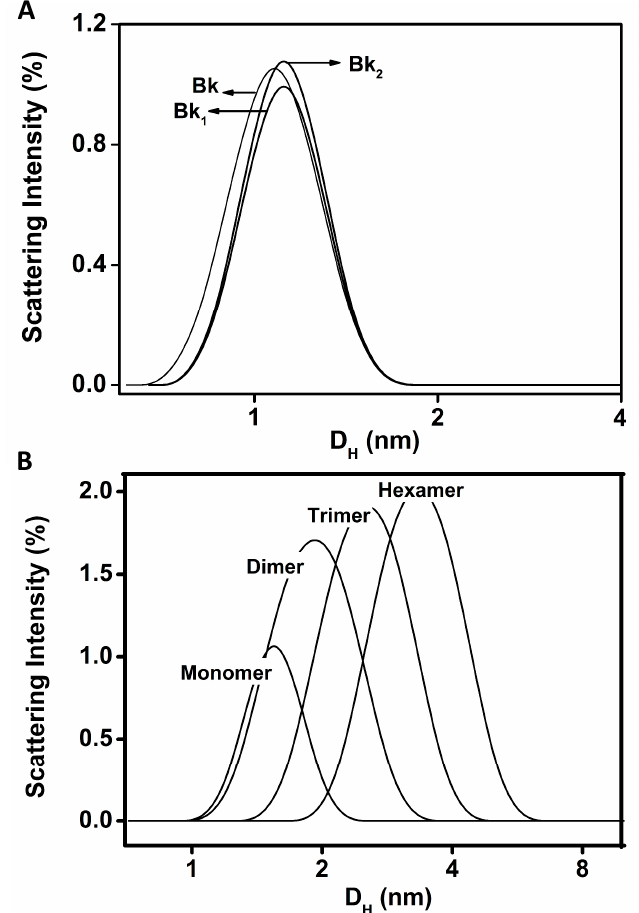
Figure 2. DLS size distribution (hydrodynamic diameter, D H ) of Bk and its analogues ( A ), BTCI ( B ) and the BTCI-Bk-related peptide complexes ( C